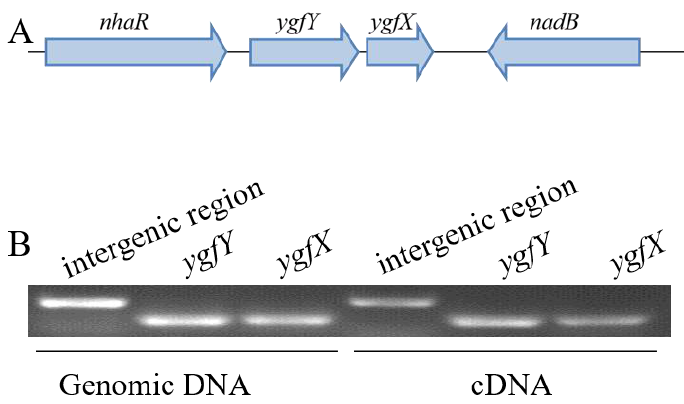
Figure 2. The ygfY located in an operon with ygfX . ( A ) Schematic of arrangement of ygfY , ygfX and their neighbor genes in genome of S. oneidensis MR-1. ( B ) Transcription of ygfY and ygfX and intergenic region between them.